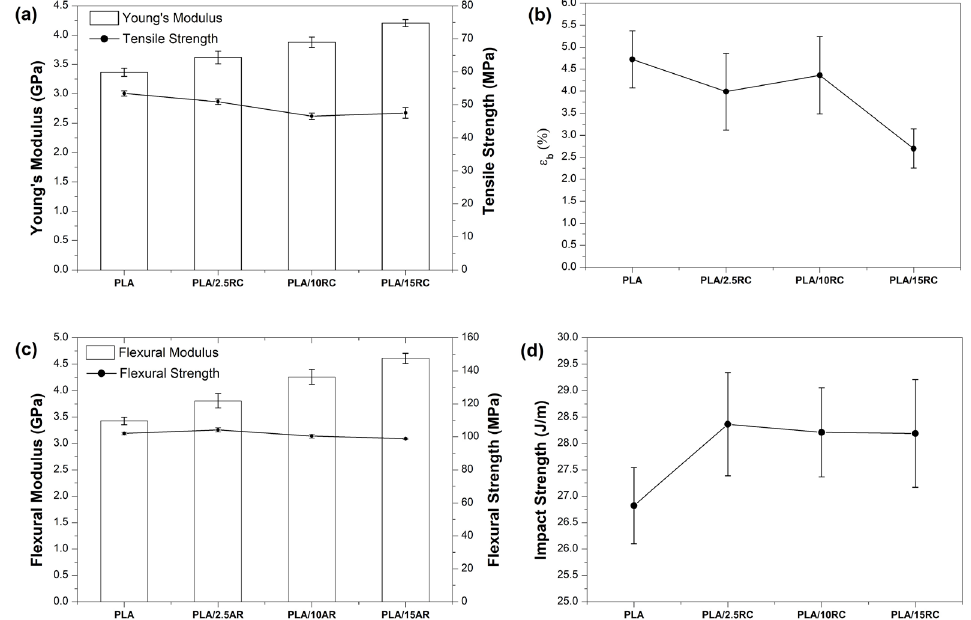
Figure 2. Mechanical behavior of neat PLA and PLA/RC composites: (a) Young’s modulus and tensile strength, (b) elongation at break, (c) flexural modulus and strength, (d) impact strength.